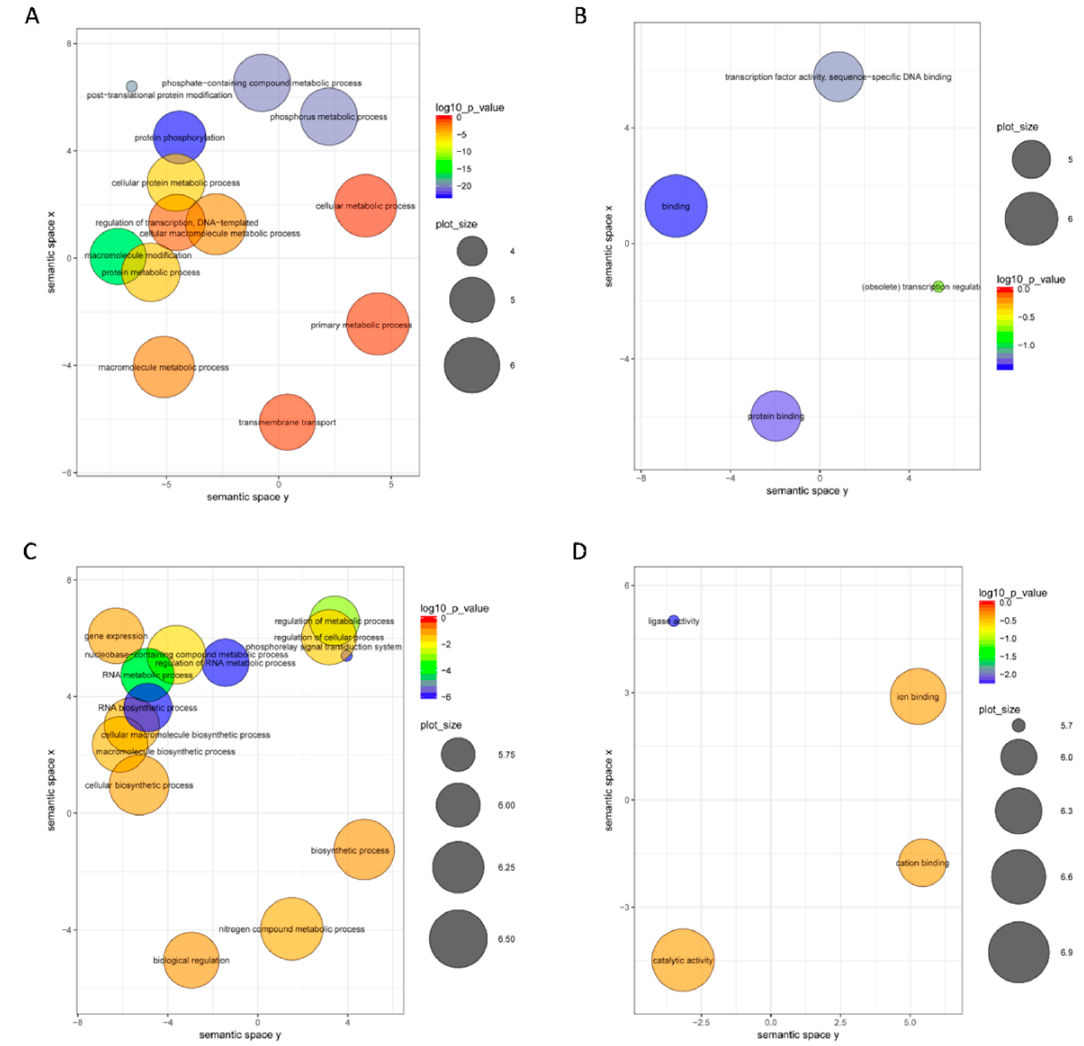
Figure 7. GO enrichment analysis targeting genes of differentially expressed miRNAs in BG and BS. ( A ) Biological process of GO enrichment analysis for upregulated miRNA target genes; ( B ) molecular function of GO enrichment analysis for upregulated miRNA target genes; ( C ) biological process of GO enrichment analysis for downregulated miRNA target genes; ( D ) molecular function of GO enrichment analysis for downregulated miRNA target genes.